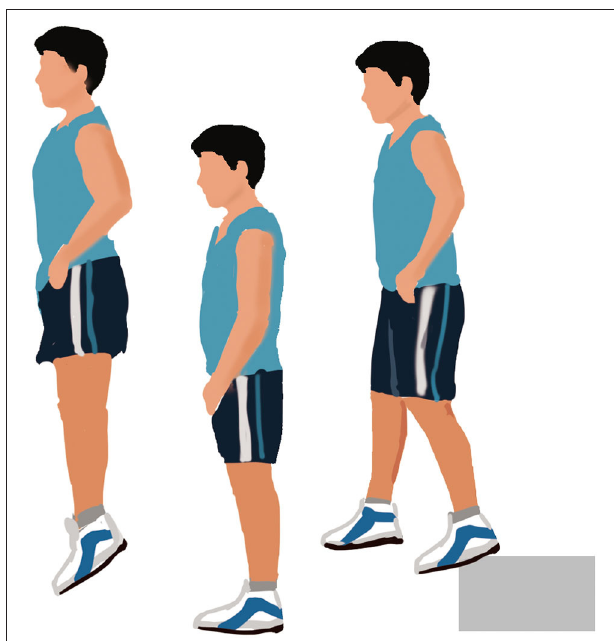
FIGURE 5 | Reactive Strength Index (RSI)